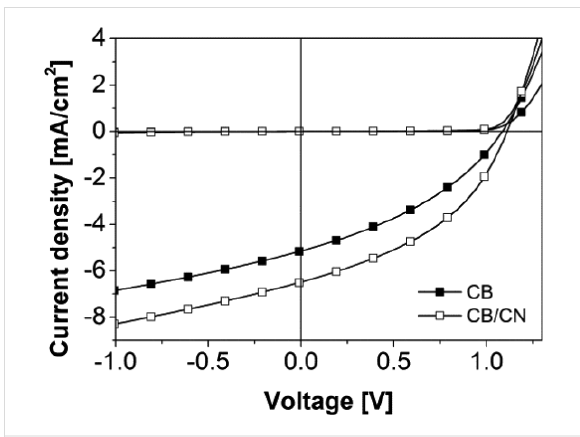
Figure 3: J – V curve of DCV5T-Bu 4 :PC 61 BM solution-processed solar cells made from 1:1 blends spin-coated from chlorobenzene solutions at 80 ˚ C with (white squares) and without (black squares) the 1-chloronaphthalene